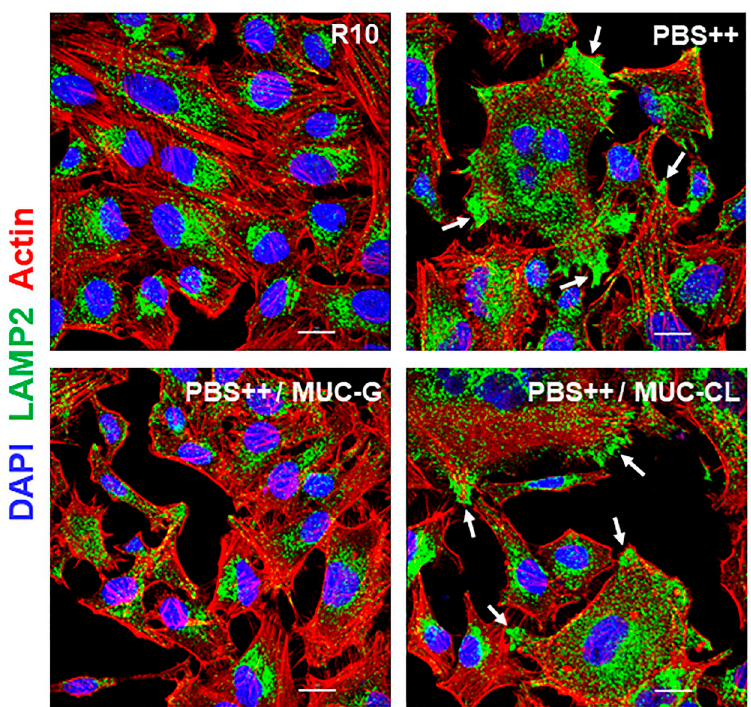
Fig 3. Inhibition of PBS ++ -induced lysosome spreading by MUC-G. HeLa cells were incubated for 30 min in RPMI containing 10% serum (R10) or in PBS ++ , in absence or in the presence of 40 μ g/ml MUC-G or MUC-CL, and then processed for immunofluorescence analysis for detection of lysosome (green), actin (red) and nucleus (blue) by confocal microscopy. Scale bar = 20 μ m. Note the PBS ++ -induced lysosome spreading, with accumulation of lysosomes at the cell edges (white arrows) and inhibition by